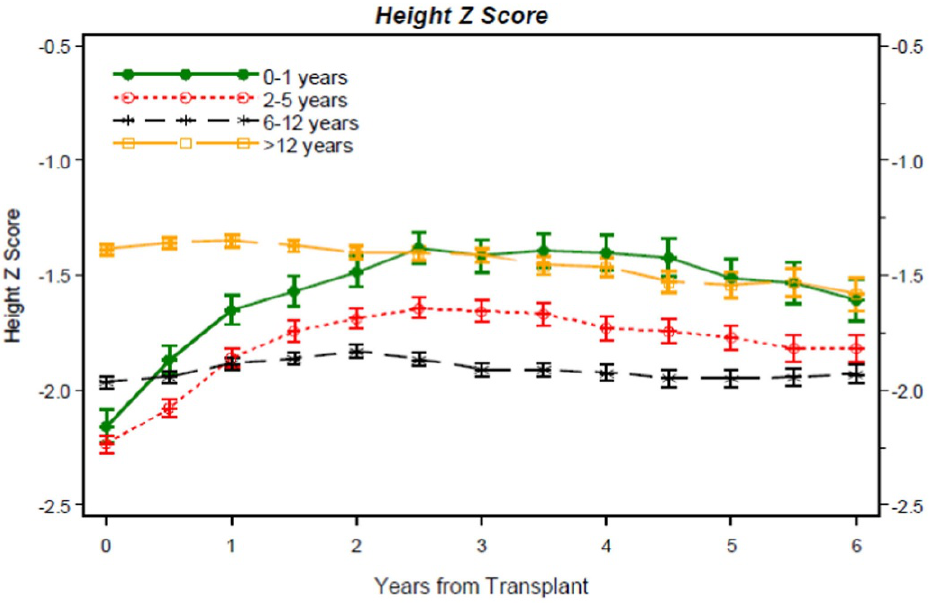
Figure 2 - Catch-up growth according to the age at renal transplantation. Taken from the NAPRTCS 2011 Annual Report